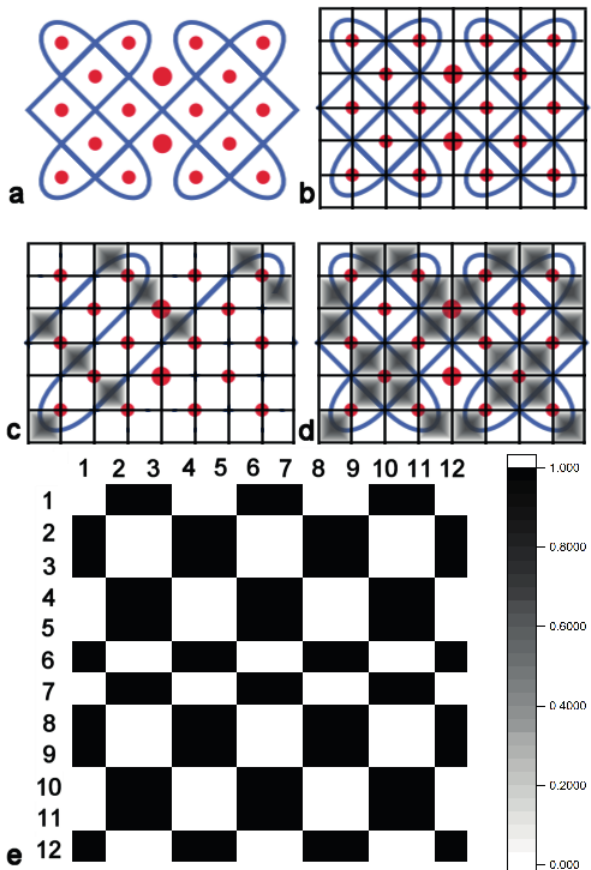
Figure 4. Steps involved in the conversion of a lusona drawing into a simplistic checkerboard pattern. The lusona in (a) repre- sents a nest of doves. A grid defined by dots in the sand (red cir- cles) is then formed over the drawing (b). The squares of the grid crossed during the drawing of the continuous curve are alternately marked as black or white (c), yielding a distinct black-and-white pattern (d), which is then redrawn without the underlying lusona and extended to the dimensions comparable with the cell distance matrix (in this case 12 x 12 starting from a 8 x 6 sona)